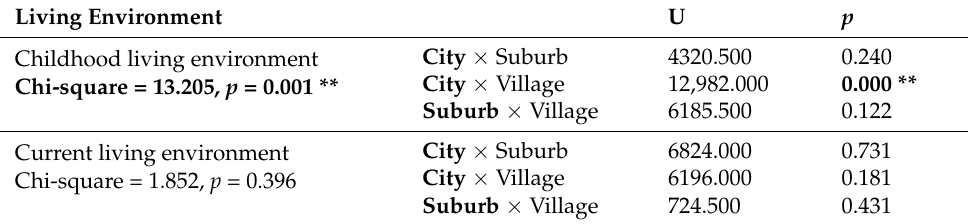
Table 3. The impacts of childhood and current living environments on self-rated health status a . Living Environment U